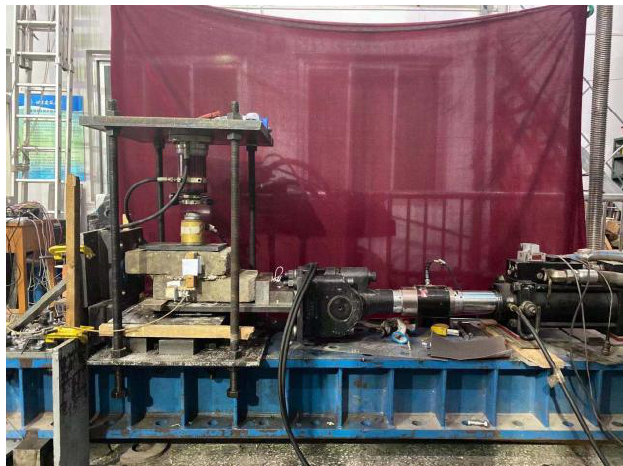
Figure 11. Sketch of the mortar joint shear tests.